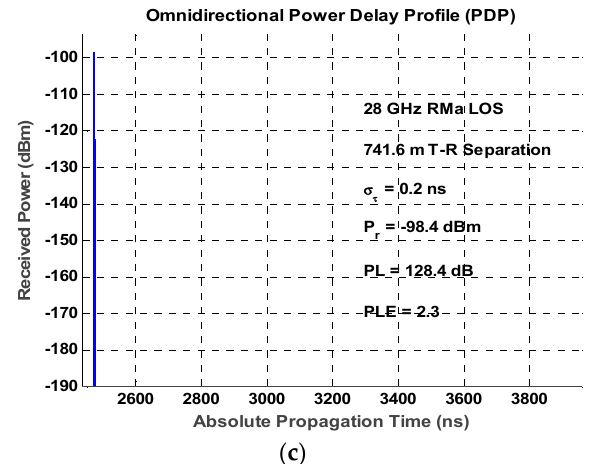
Figure 4. Power delay profile generated from NYUSIM simulator: ( a ) Umi scenario; ( b ) Uma scenario; ( c ) Rma scenario.